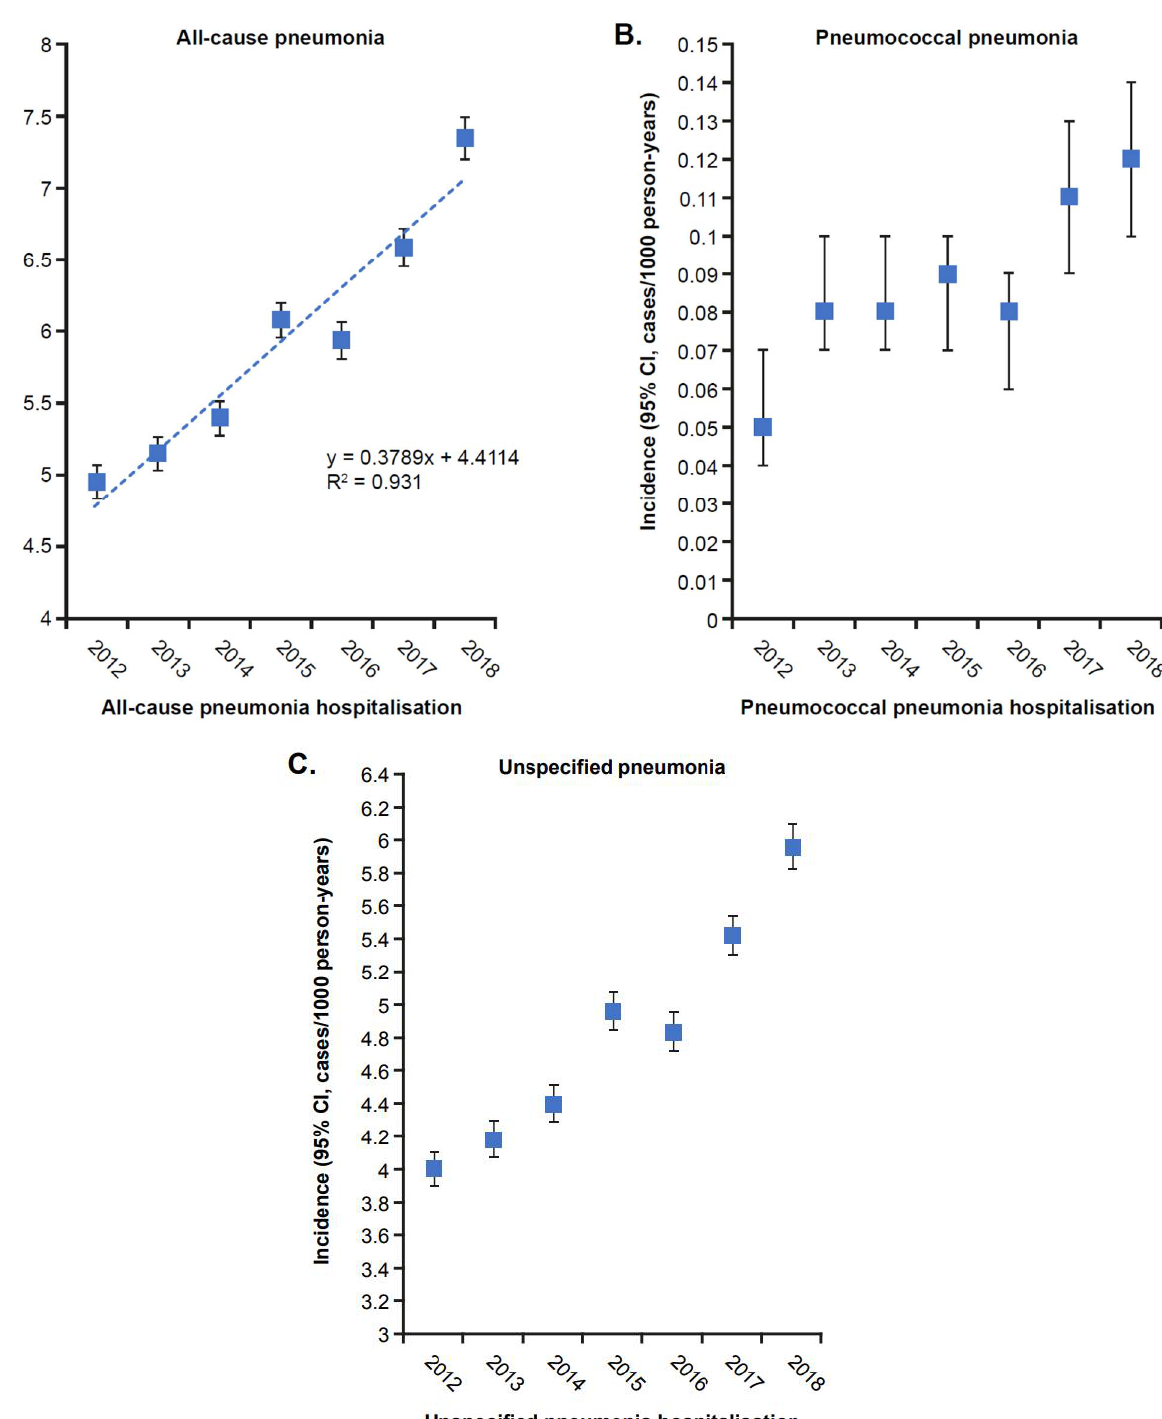
Figure 2. Annual incidence of ( A ) all-cause, ( B ) pneumococcal, and ( C ) unspecified pneumonia hospitalisation in adolescents and adults ≥15 years of age in Liguria, Italy (2012–2018). CI: confidence interval.